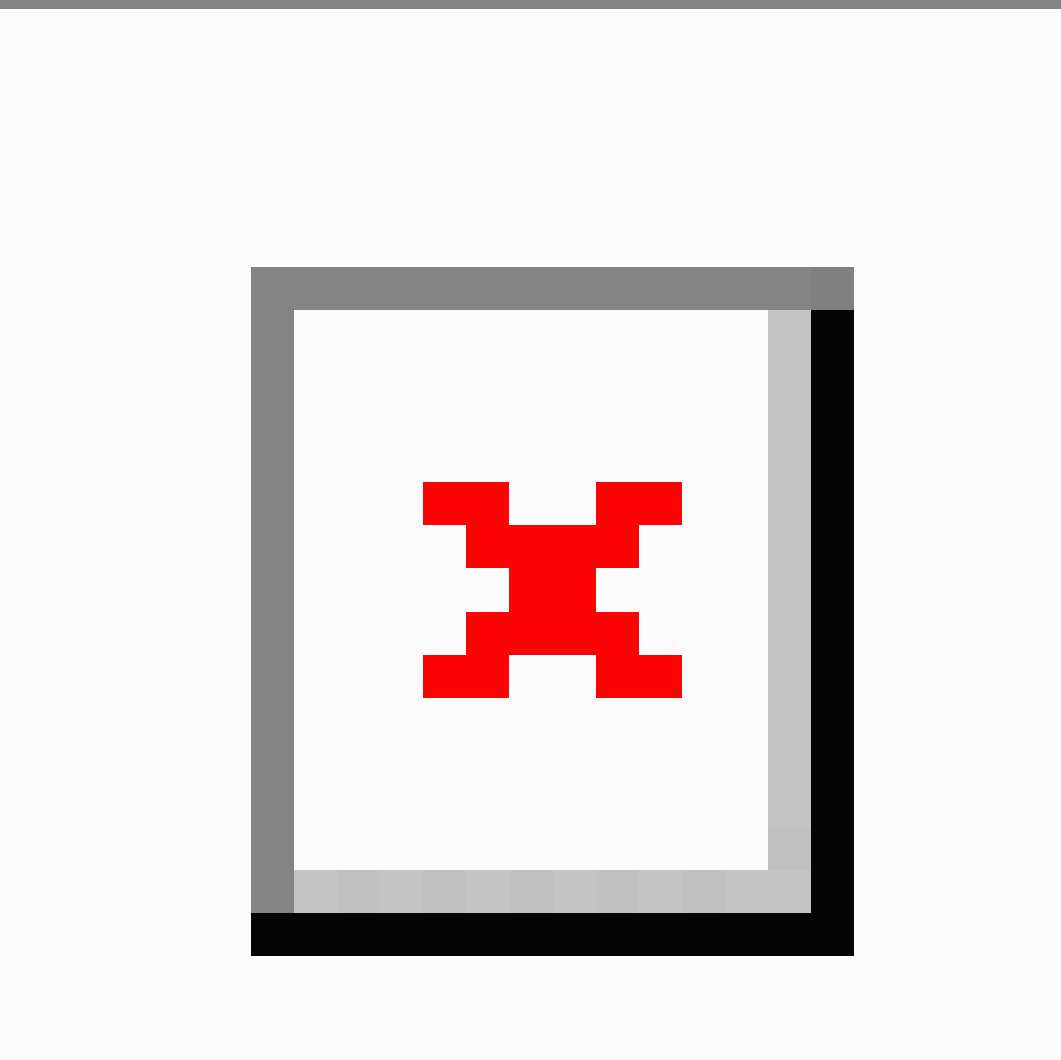
Figure 5. Representative example of (A) drift in the device electrical signal and (B) ECG signal after drift filtering. Data from MIT-BIH Arrhythmia Physionet database #103. Representative examples of relatively low frequency artificial electrical spikes (C) before and (D) after filtering. Data from MIT-BIH Arrhythmia Physionet database #105. Representative examples of relatively high frequency artificial electrical spikes (E) before and (F) after R peak detection. The “x” symbol represents the R peak detected by the algorithm. Data from MIT-BIH Arrhythmia Database